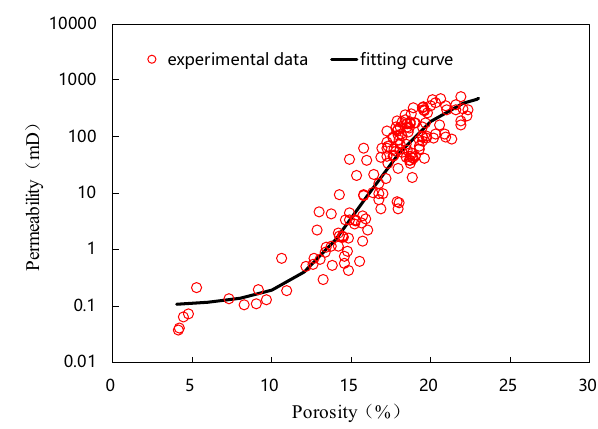
Fig. 5 The relationship between porosity and